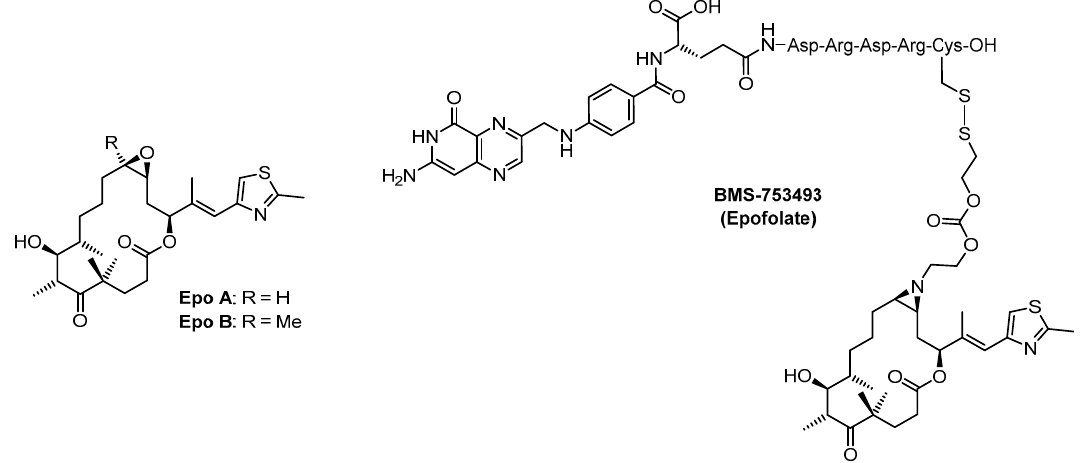
Figure 1. Molecular structures of epothilones A and B and of the tumor-targeted epothilone conjugate BMS-753493 (epofolate).